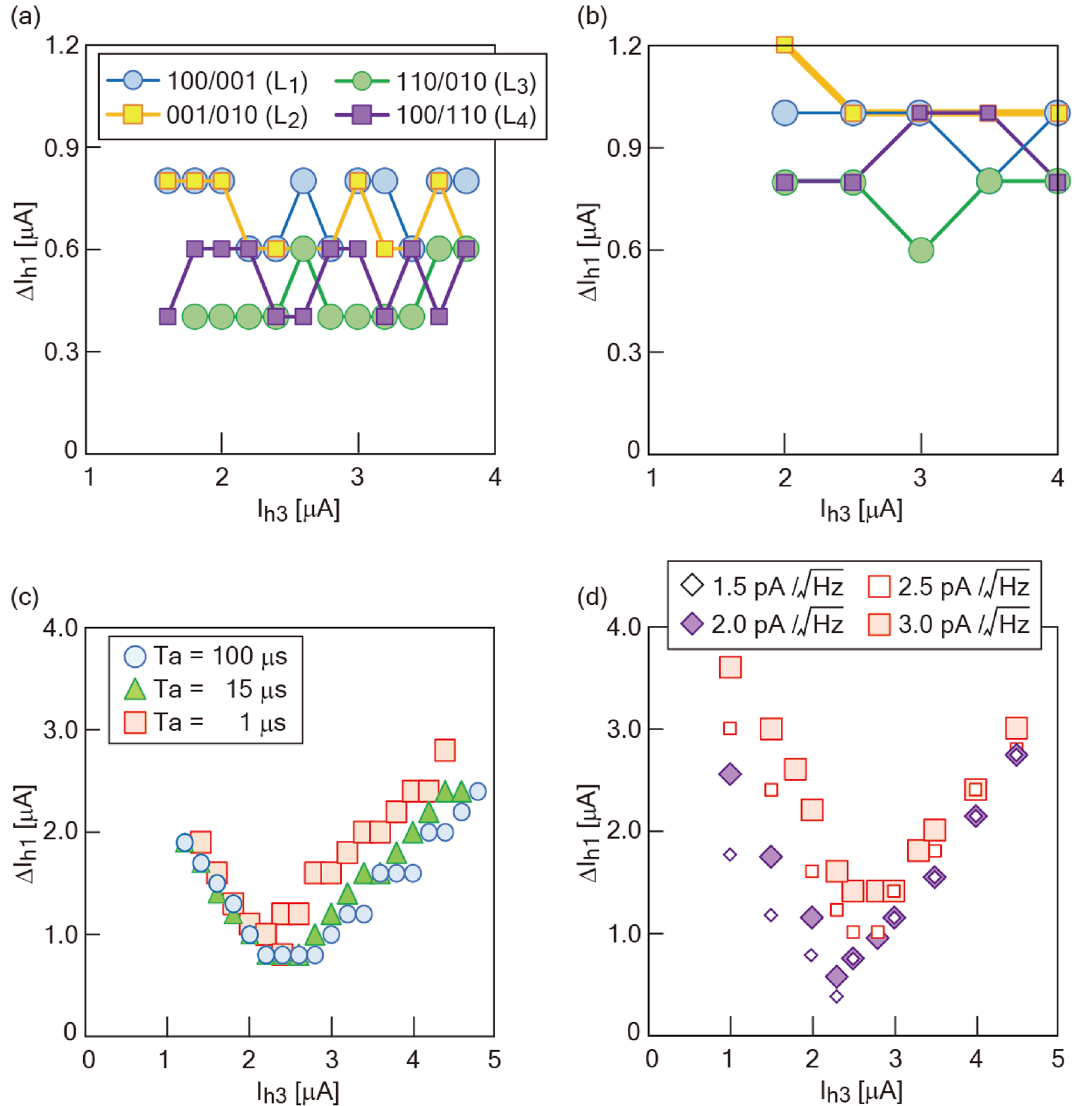
Figure 3. | Gray zone analysis. Type I gray zone analysis in ( a ) 10 mK experiment and ( b ) JSIM analysis. The inset of ( a ) represents the theoretical analysis. In the JSIM analysis of ( b ), a thermal noise current of 3.0 pA/√Hz is adopted. Type II gray zone analysis in ( c ) 10 mK experiment and ( d ) JSIM analysis. NOR2 is Supplementary Fig. 11 and the “Calibration of the degeneracy point in experiment” section of the Supplementary Note). The calibrated degeneracy points are ( I h1 , I h2 , I h3 ) = (1.6, 1.7, 3.0) [µA] in NOR1 and (1.6, 1.6, 2.9) [µA] in NOR2. Since the smallest half-width of the gray zone is about 0.2 µA, the degeneracy point is almost consistent between theory and experiments. Qubits consisting of NOR1 and NOR2 are designed as the value of a dimen- sionless factor β L = 2π LI c /Φ 0 (Φ 0 is the flux quantum) of 4.2 and 2.5, respectively, which is designed to construct an energy potential without a local minimum state. As a result, by considering the calibration of the offset flux, the experimental degeneracy point is quantitatively close to the theoretical one. Since the experimental degen- eracy point is predictable from consideration of the theoretical one and the offset flux, both high accuracy and controllability are possible with the combination of this superconducting quantum circuit of NOR. In order to achieve true QA, the suppression of noise effects, including thermal noise, magnetic flux noise from the environment, and electric noise, is vital. The impact of thermal noise is suppressed for experiments carried out at 10 mK. Our experimental setup supports the evaluation of state transitions in the Josephson junc- tion (JJ) with a switching current of 0.28 µA, which is small compared with I c in NOR1 and NOR2. The primary origin of noise that affects the Type I gray zone is the noise floor from the dc power supply used for the current source. The dc power supply consisting of a noise floor of order fA/√Hz is used to suppress the electric noise from instruments. Supplying the external bias current I h to the circuit of the qubit contributes to eliminating the negligibly small electric noise compared to the thermal energy at 10 mK. Supplementary Fig. 12 represents the expanding width of the gray zone up to 1 µA when the experiment is performed using a dc power supply with a three-orders-of-magnitude higher noise floor compared with the one used in Fig. 1 (see the “Suppression of